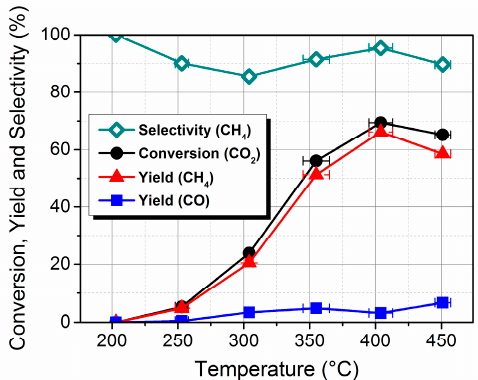
Figure 2. Conversion of CO 2 (black), yield of CH 4 (red) and yield of CO (blue), as well as selectivity of CH 4 (green) for the 10 wt % Ni/Al 2 O 3 catalyst; conditions: stainless steel tubular fixed-bed reactor, 150 mg catalyst, H 2 /CO 2 = 4, 75% N 2 , p = 1 atm, T = 200–450 °C, gas hourly space velocity (GHSV) of 26,700 h − 1 and weight hourly space velocity (WHSV) of 12,000 mL CO2 /(g cat ·h). The formation of CH 4 started between 200 and 250 °C, and the conversion of CO 2 increased with rising temperature, reaching the highest value of 69% at 400 °C at a maximum selectivity towards